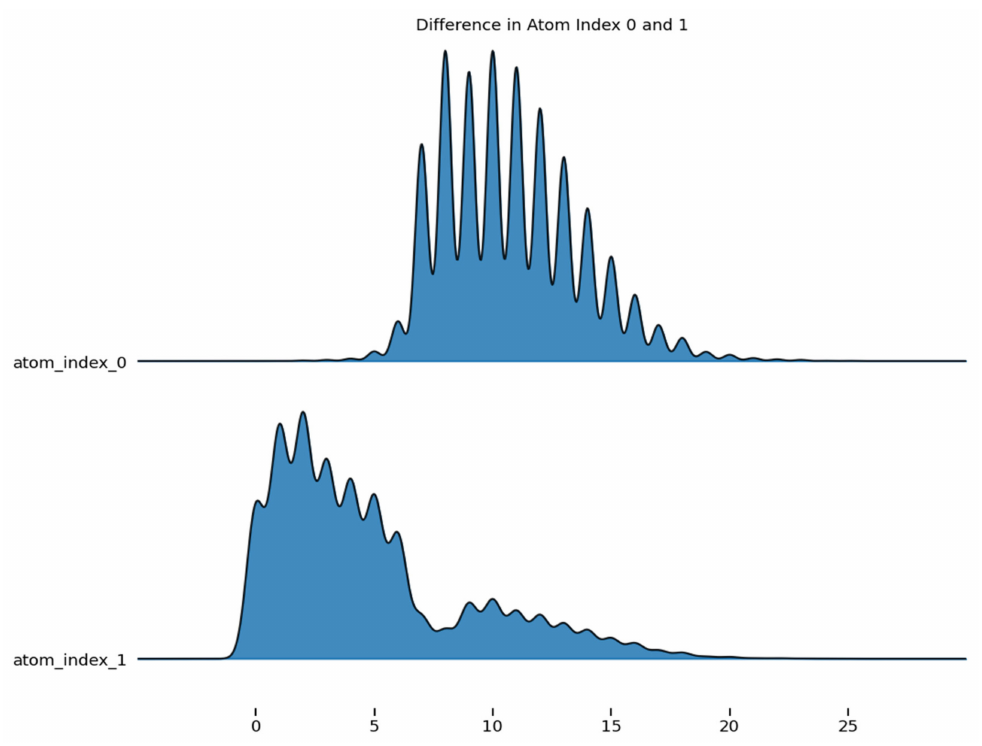
Figure 5. Difference in the atom index of molecular properties.